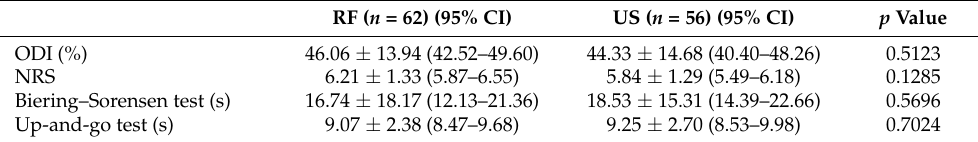
Table 2. Baseline clinical parameters in both